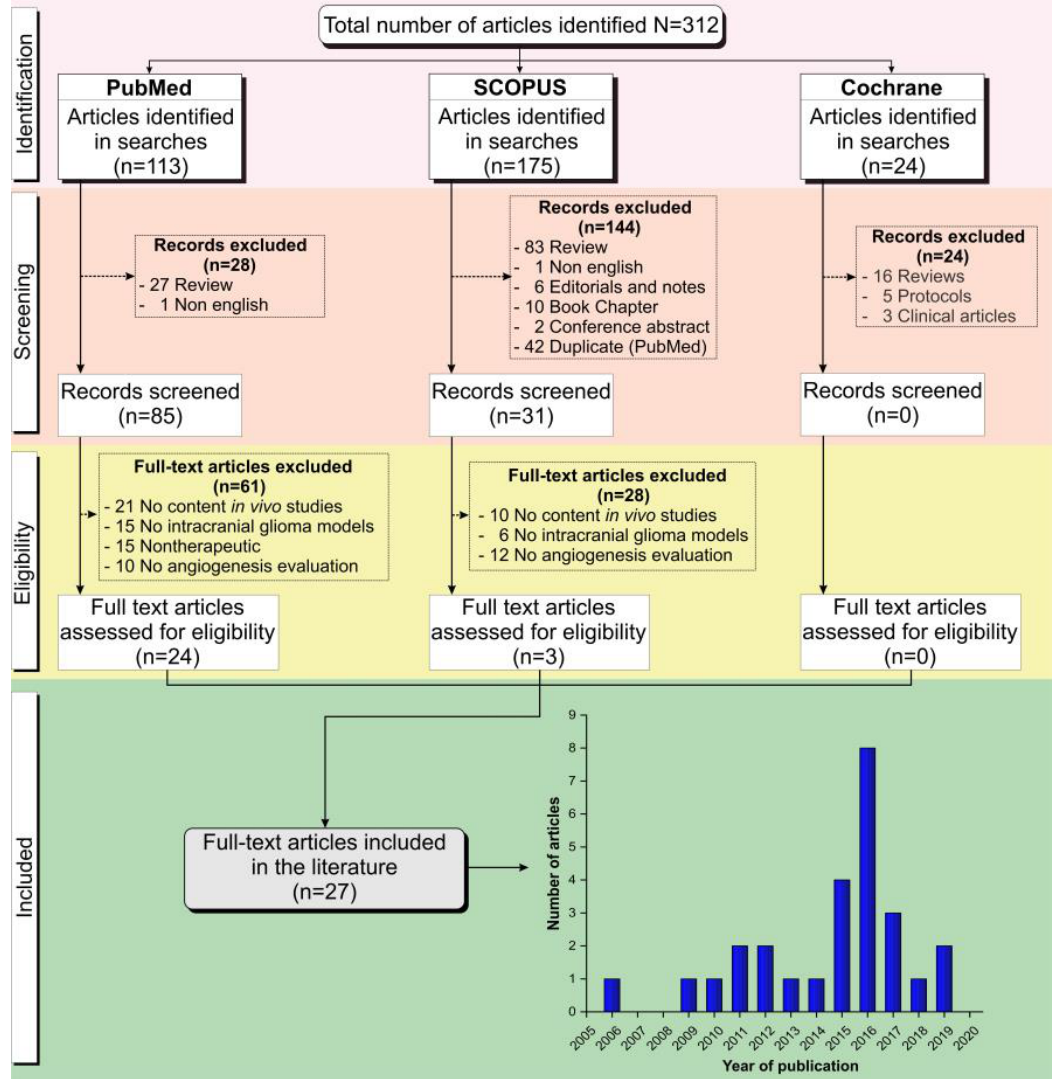
Figure 1. Flowchart corresponding to the stages of the Preferred Reporting Items for Systematic Reviews and Meta-Analyses (PRISMA) guidelines [49] of the article screening process for inclusion in this